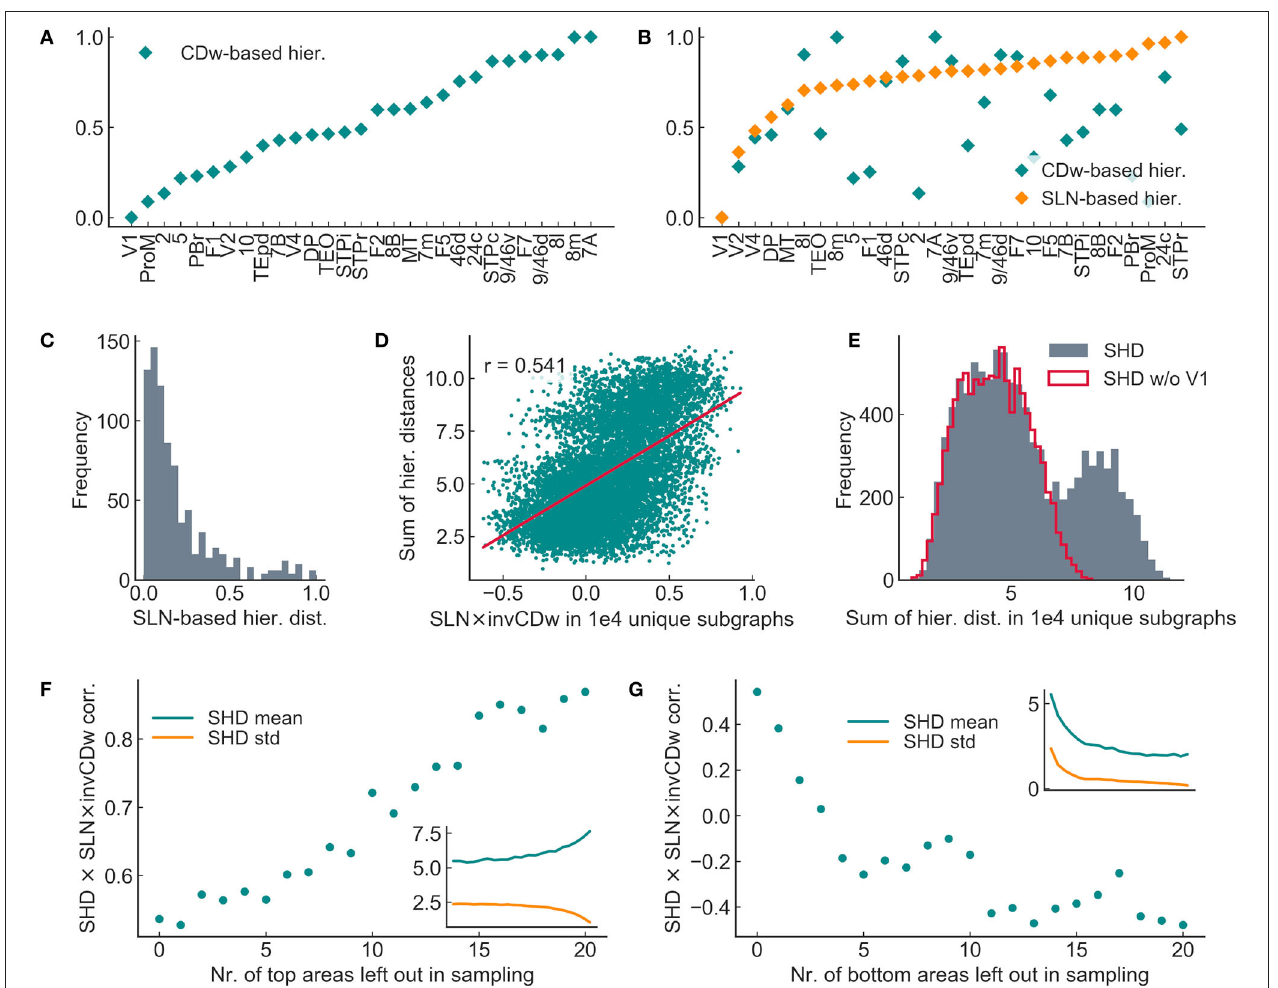
FIGURE 10 | Spread of hierarchical distance determined the SLN × invCDw correlation in 8 × 8 subgraphs sampled randomly from the entire 29 × 29 graph. (A) CD-based hierarchy of areas in the entire graph. (B) SLN-based hierarchy of areas in the entire graph, with the corresponding CD-based hierarchical values also shown. The two hierarchies did not correlate in the full graph. (C) Distribution of SLN-based hierarchical distances for the entire graph. (D) The sum of SLN-based hierarchical distances (SHD) showed a highly significant positive correlation with the SLN × invCDw correlation in the random sample of subgraphs. (E) The overall large hierarchical distances of V1 (see B ) significantly influenced the distribution of sample sums of hierarchical distances (SHDs). The bimodal histogram turned to unimodal after omitting V1 (SHD w/o V1). (F,G) The SHD and SLN × invCDw correlation changed in a consistent manner by leaving out nodes from subgraph sampling according to their position in the SLN-based hierarchy. The omission of the top areas increased the correlation (F) while leaving out bottom areas decreased the correlation (G) . This result implies that in the ideal case of large anatomical hierarchical distances, the correlation between the invCDw and the SLN and thereby between the invCDw and the mDAI would be maximal. The notations are the same as in the previous